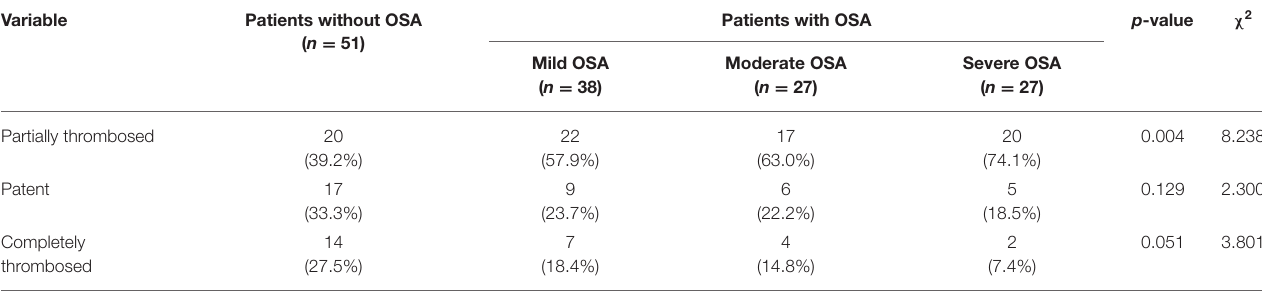
TABLE 5 | Thrombosed FL with different OSA severity levels. Variable Patients without OSA ( n =